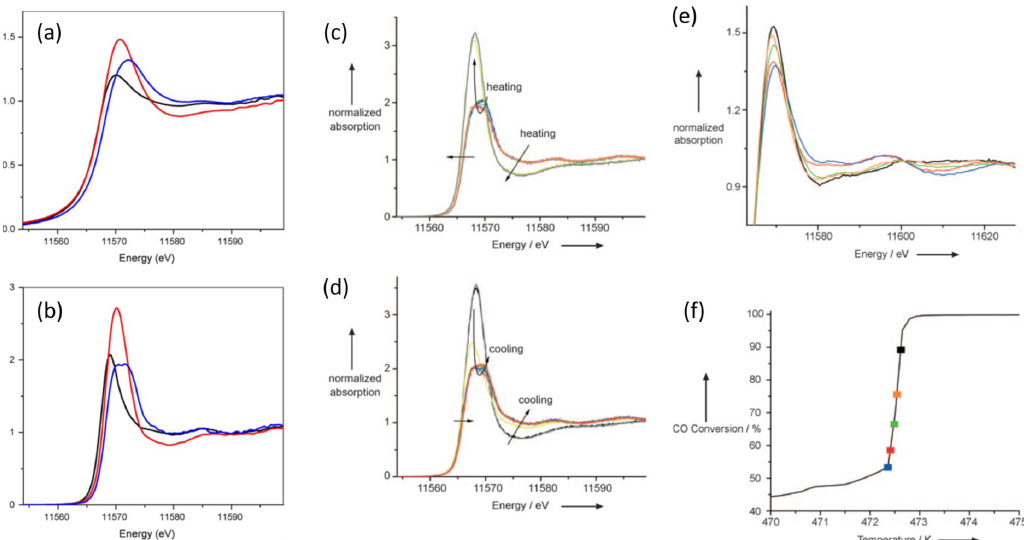
Figure 11. ( a ) Pt L 3 -edge XANES from 2 wt % Pt/Al 2 O 3 catalysts obtained using standard XAFS in transmission. ( b ) Pt L 3 -edge XANES from supported Pt catalysts obtained using fluorescence